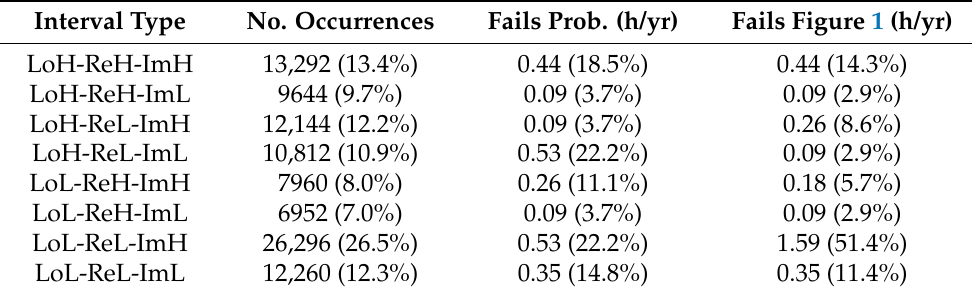
Table 4. Number of intervals belonging to each cluster of the probabilistic dimensioning method and corresponding number of incidents within each